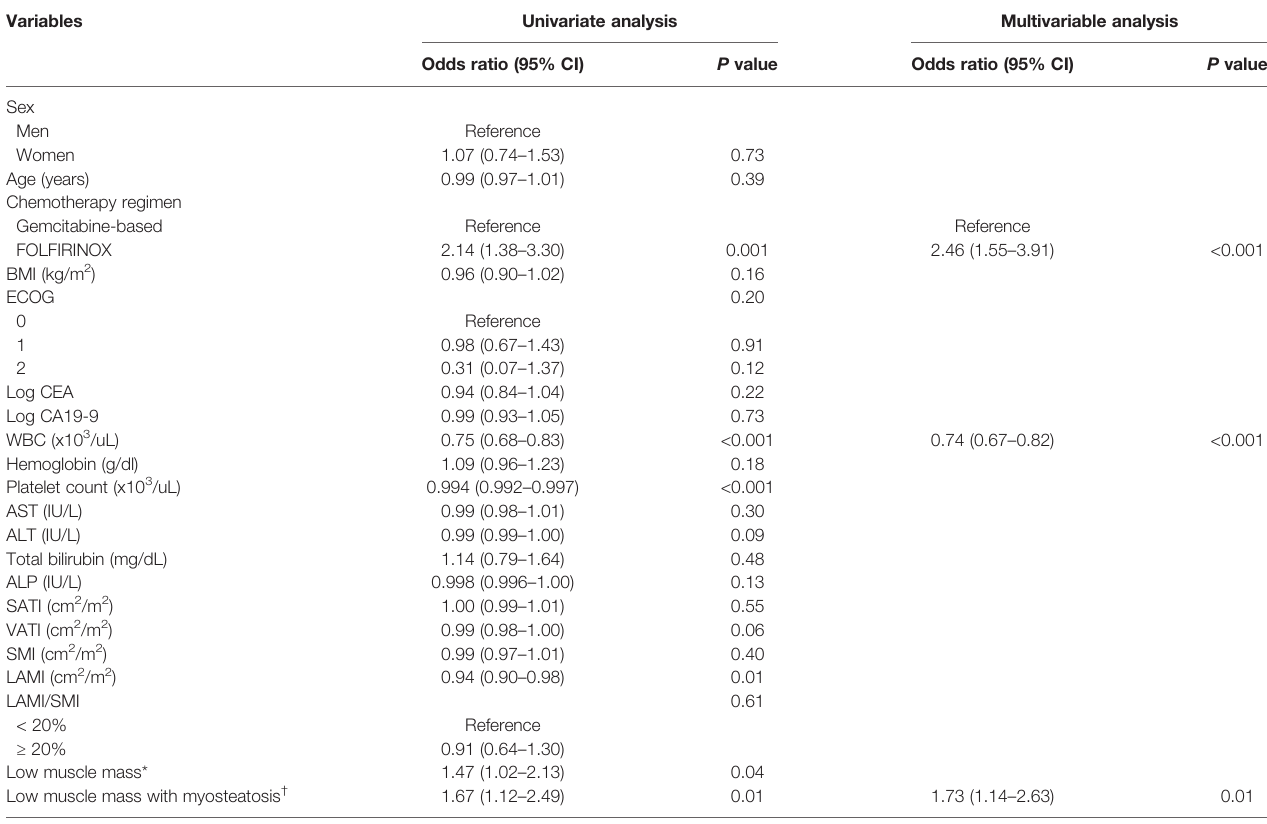
TABLE 3 | Univariate and multivariable analyses of the occurrence of grade 3 – 4 toxicity.